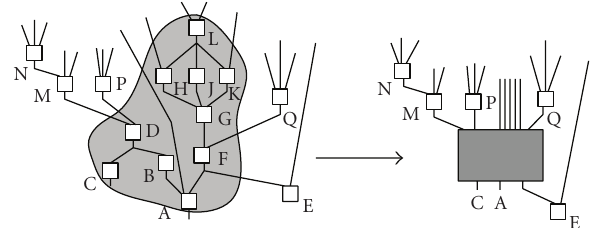
Figure 1: Example of mapping logic to a memory array.